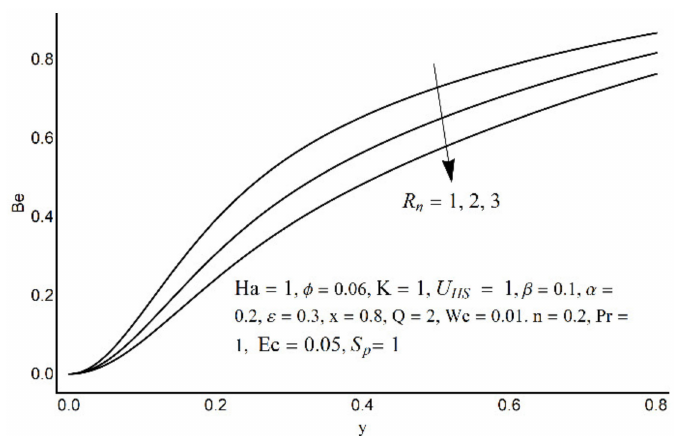
Figure 20. The Bejan number at various R n .